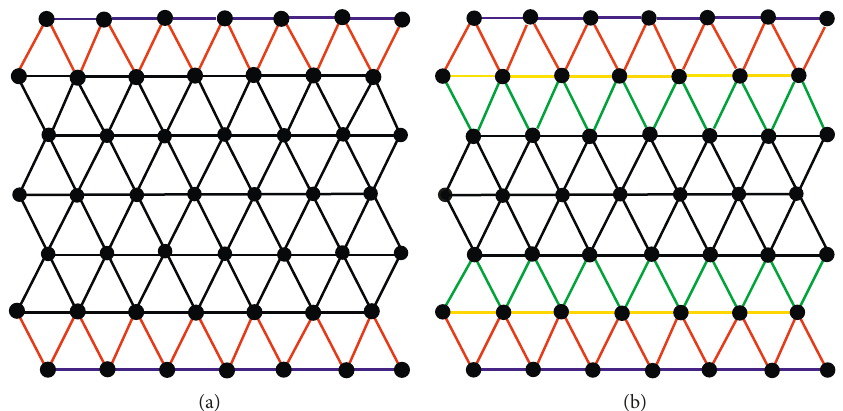
Figure 3: The edge partitions of BT [ 7 , 4 ] nanotube: (a) with respect to degree of end vertices; (b) with respect to degree sum of neighbor